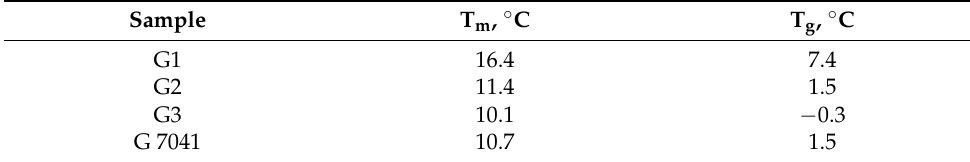
Table 7. Thermal properties of gelatin gels. Gelatin concentration was 10 wt.%.